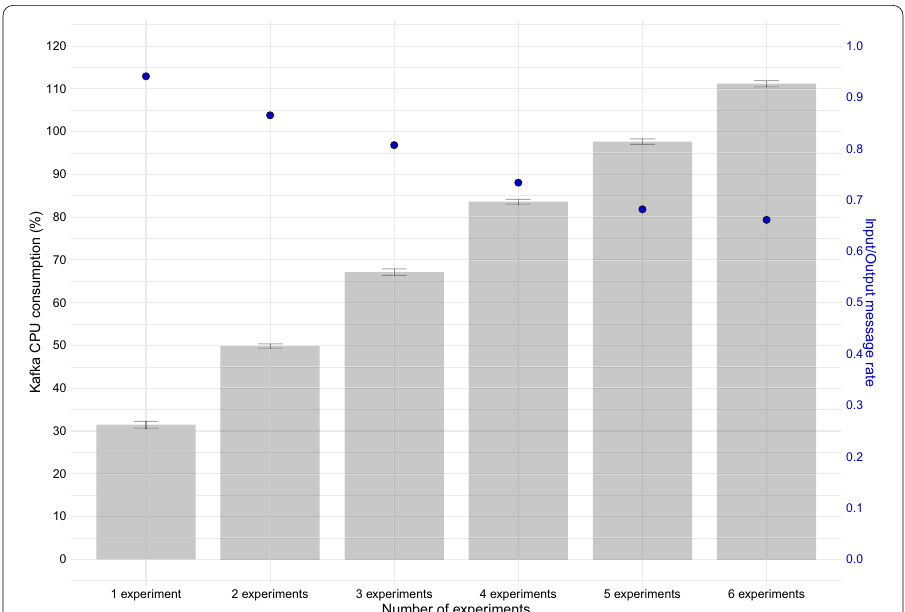
Fig. 11 Evolution of data collection manager CPU consumption and I/O message rate in multi‑broker